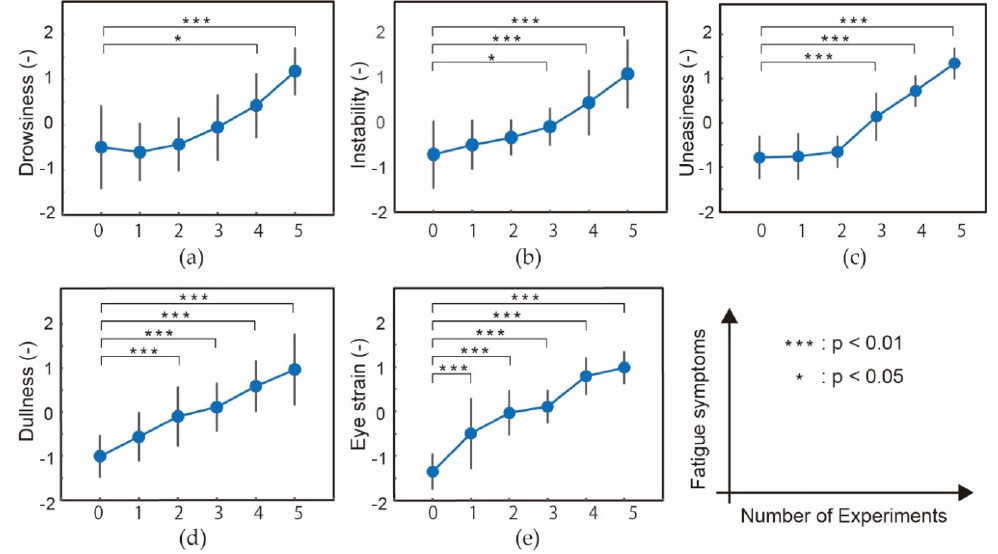
Figure 6. Normalized ( a ) drowsiness, ( b ) instability, ( c ) uneasiness, ( d ) local pain or dullness, and ( e ) eyestrain with respect to the number of U–K tests ( n = 16). “ p ” represents the p -value in statistics hypothesis testing.